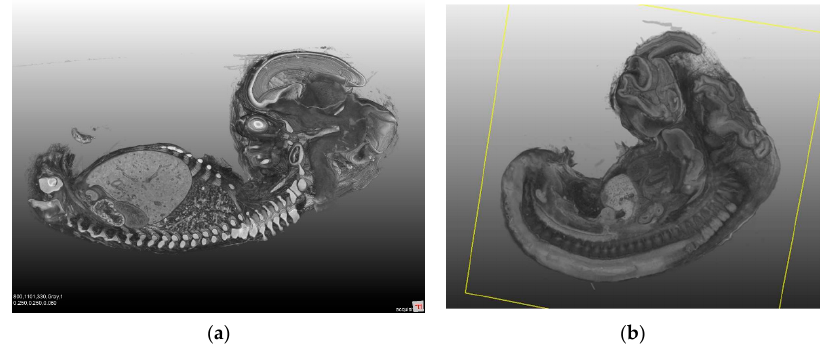
Figure 5. Lateral views of a human embryo obtained through computed tomography and magnetic resonance imaging. (a) Lateral view of an approximately-eight-week-old embryo. The human